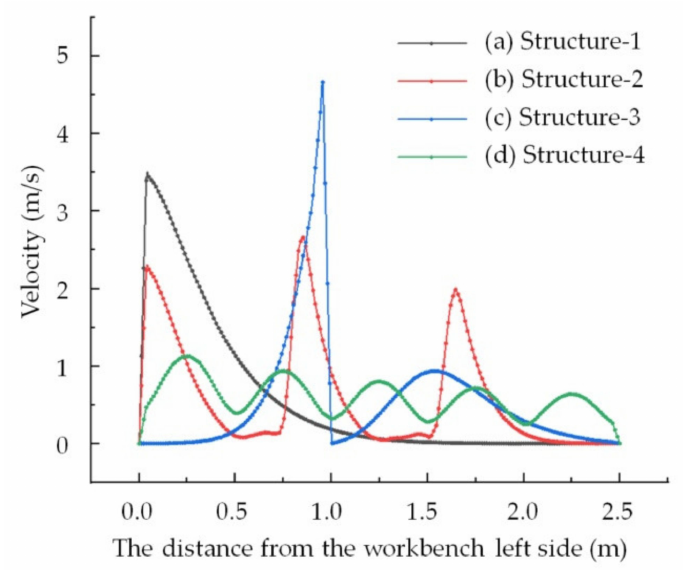
Figure 9. Workbench surface center velocity in the short side direction for differently structured workbenches studied in this paper.